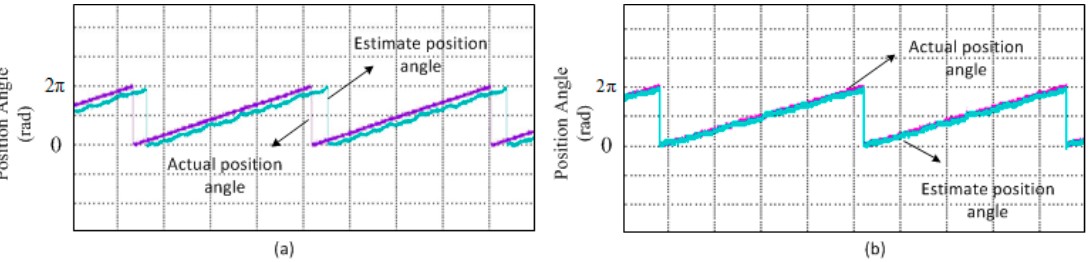
Figure 16. Angle comparison waveform after rotation: ( a ) traditional method (using filters); ( b ) method proposed in this paper.